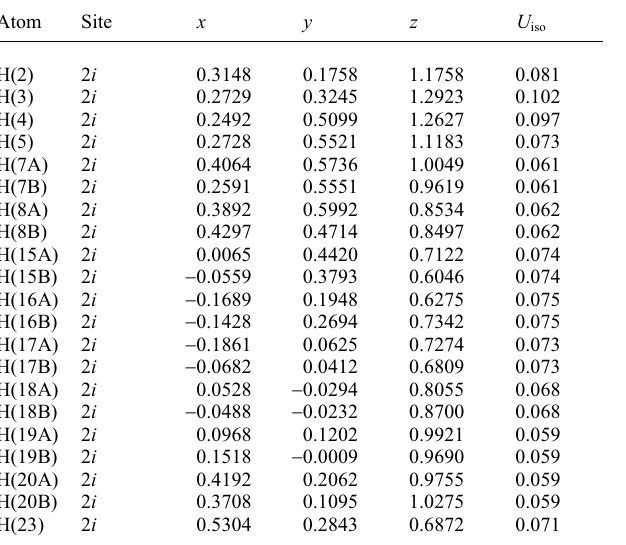
Table 2. Atomic coordinates and displacement parameters (in Å 2 )